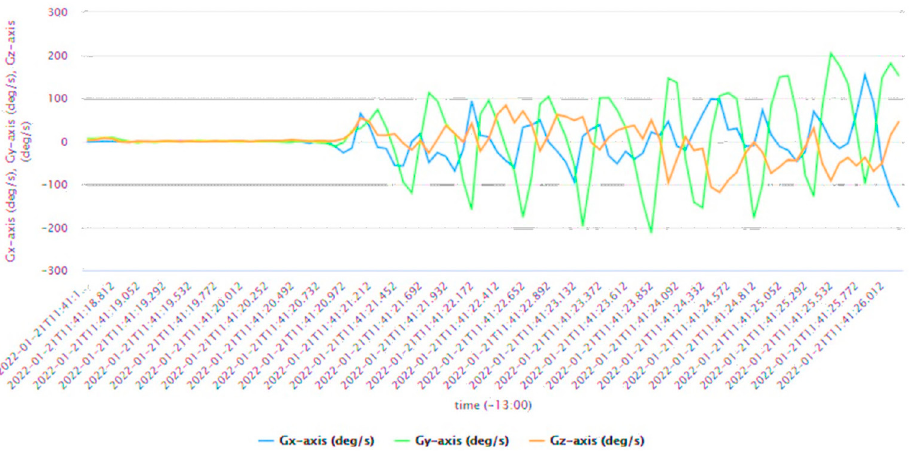
Figure 16. Variation in the gyroscope data (in X, Y, and Z directions) during the different behavioral patterns associated with these ADLs performed at different time instants.